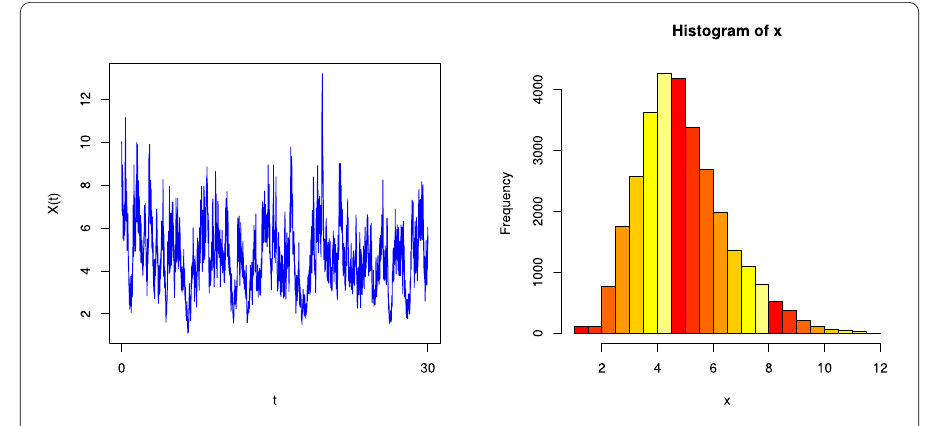
Figure 1 (Left) Computer simulation of 30,000 iterations of a single path X t of Example 5.1. (Right) The histogram of the path